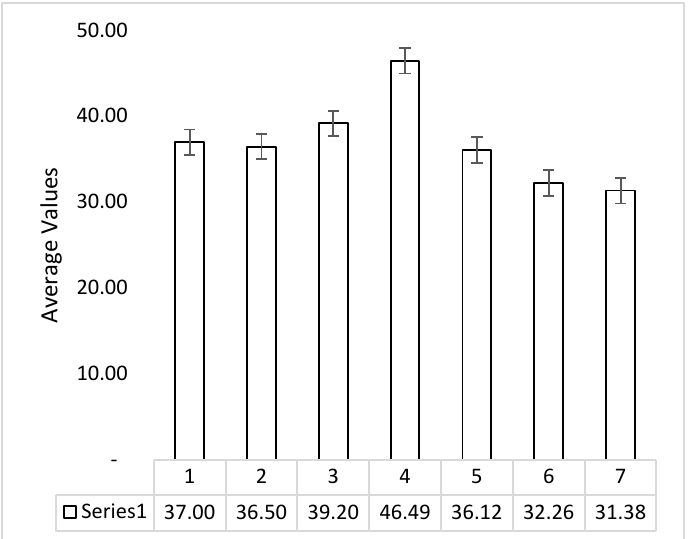
Figure 6. Error bar graph for flexural strength of ATA specimen for three samples of each group.